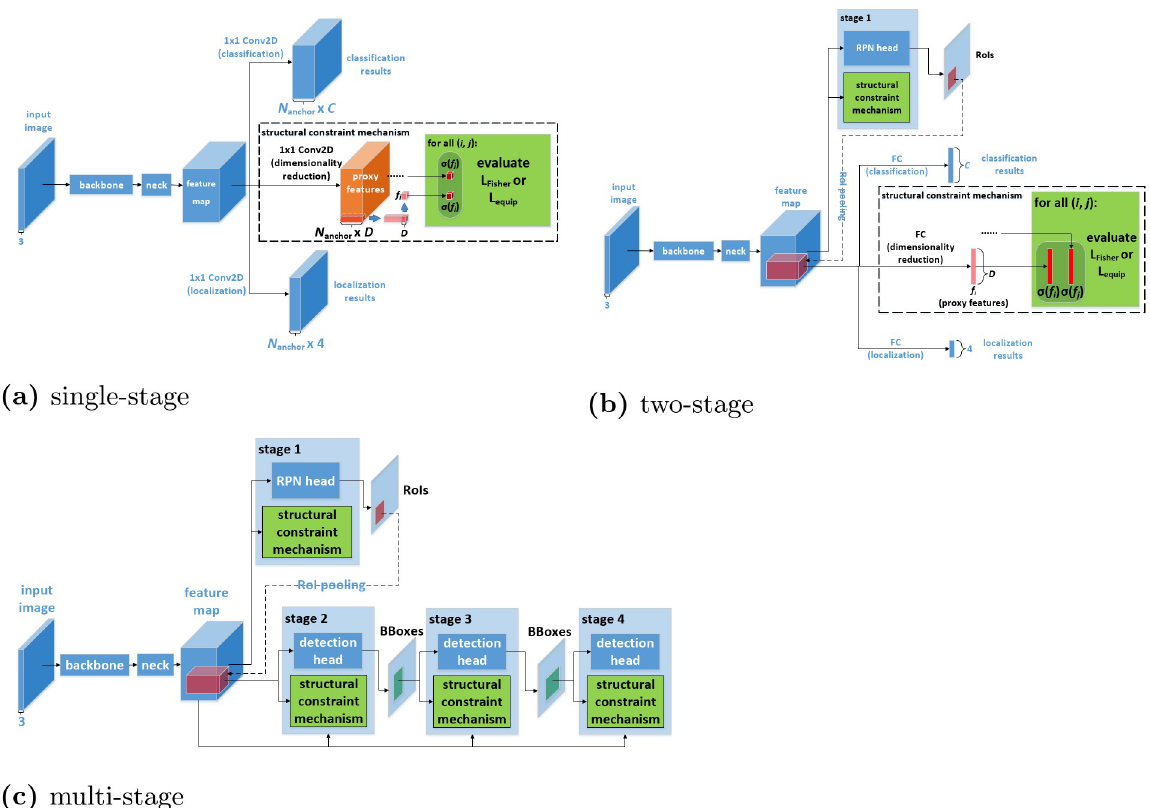
Fig 1. Illustration of structural constraint mechanisms in object detection networks of various architectures. (a) single-stage, (b) two-stage, and (c) multi-stage.